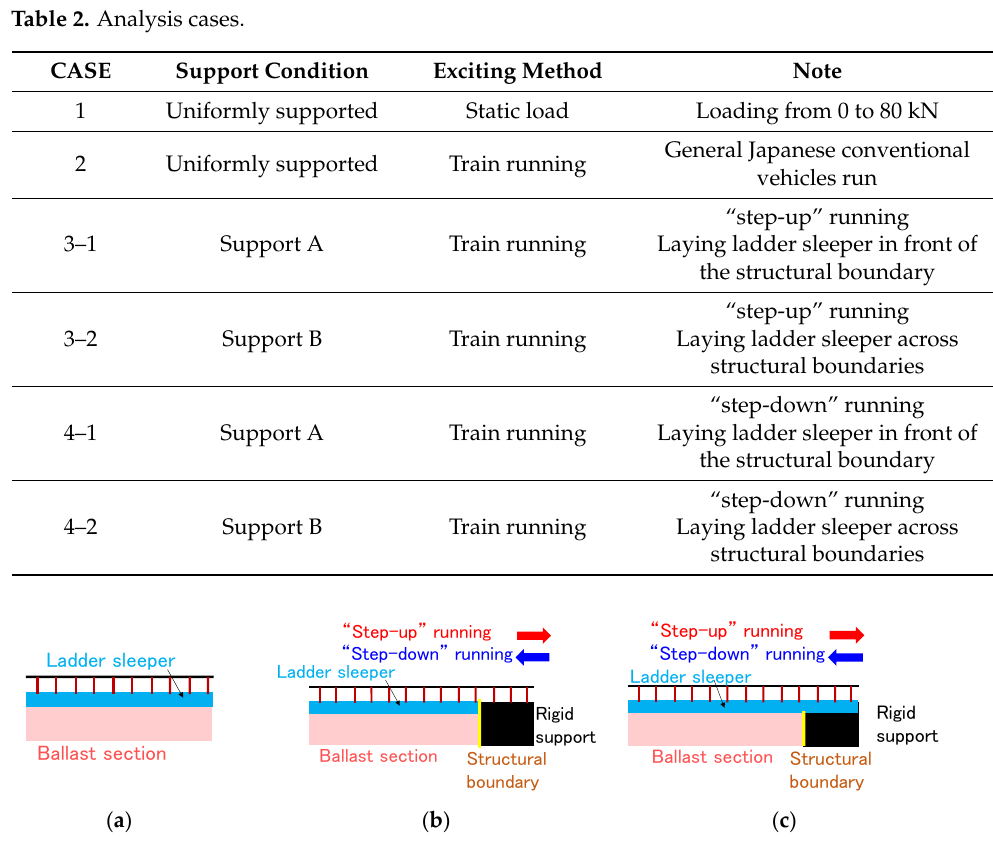
Figure 12. Outline of support condition: ( a ) uniformly supported by ballast; ( b ) Support A (laying ladder sleeper in front of the structural boundary); ( c ) Support B (laying ladder sleeper across structural boundaries).